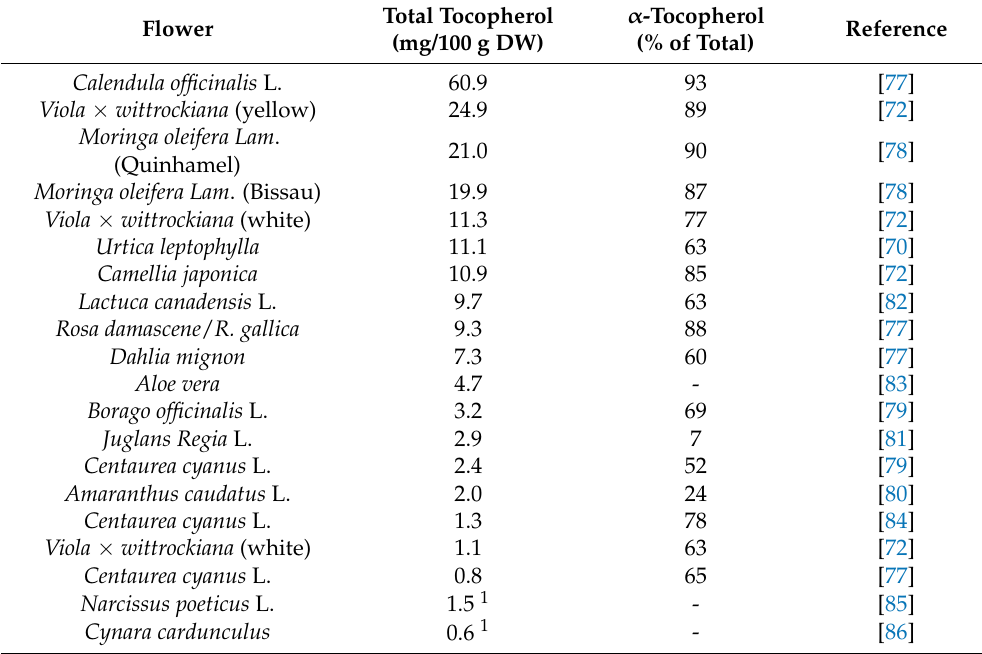
Table 10. Total tocopherol content of several edible flowers from recent studies.